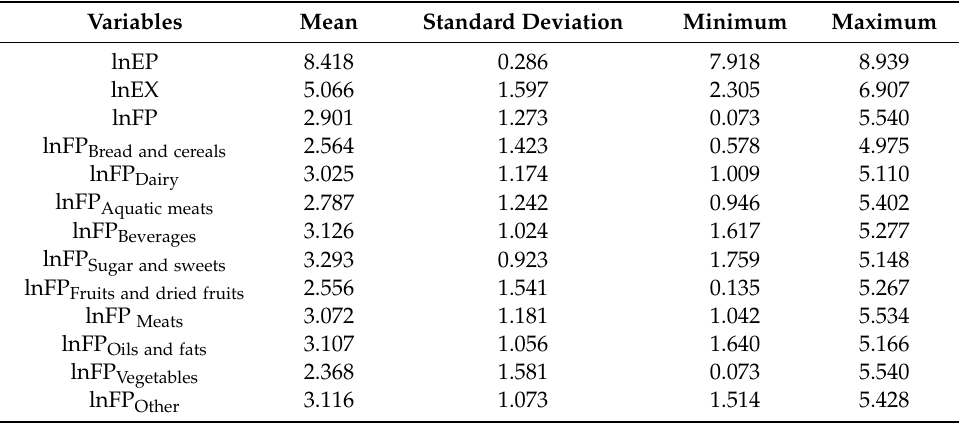
Table 1. Summary statistics of the